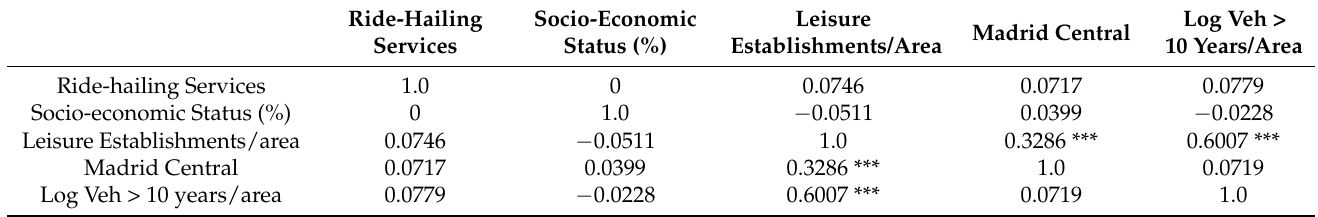
Table 4. Pearson’s correlation coefficients between variables. Source: own